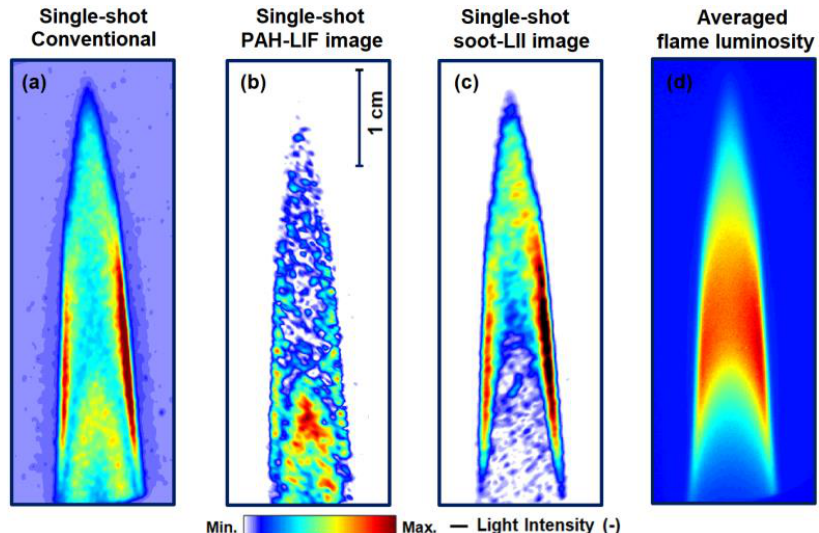
Figure 4. ( a ) “Conventional” (0th order components of FFT in Figure 1b) single-shot processed image of the flame, reconstructed after low-pass filtering of (LIF + LII) component in Figure 1b. ( b ) Processed single-shot qualitative PAH-LIF image after applying the lock-in algorithm on the FRAME image 1 in Figure 1a. Similarly, in ( c ), a processed single-shot qualitative soot-LII image is extracted. In ( b , c ), compared to ( a ), the image contrast is enhanced due to the suppression of stray lights and flame luminosity. Extinction of laser in the flame is evident from right to left in ( a , c ). However, in ( d ), some axis asymmetry between the right and left side of the flame is seen as well in terms of averaged flame luminosity, which is recorded without the lasers. This could be due to the weak flickering of the flame. Images are intensity-adjusted to pronounce the gradients of the probed species.